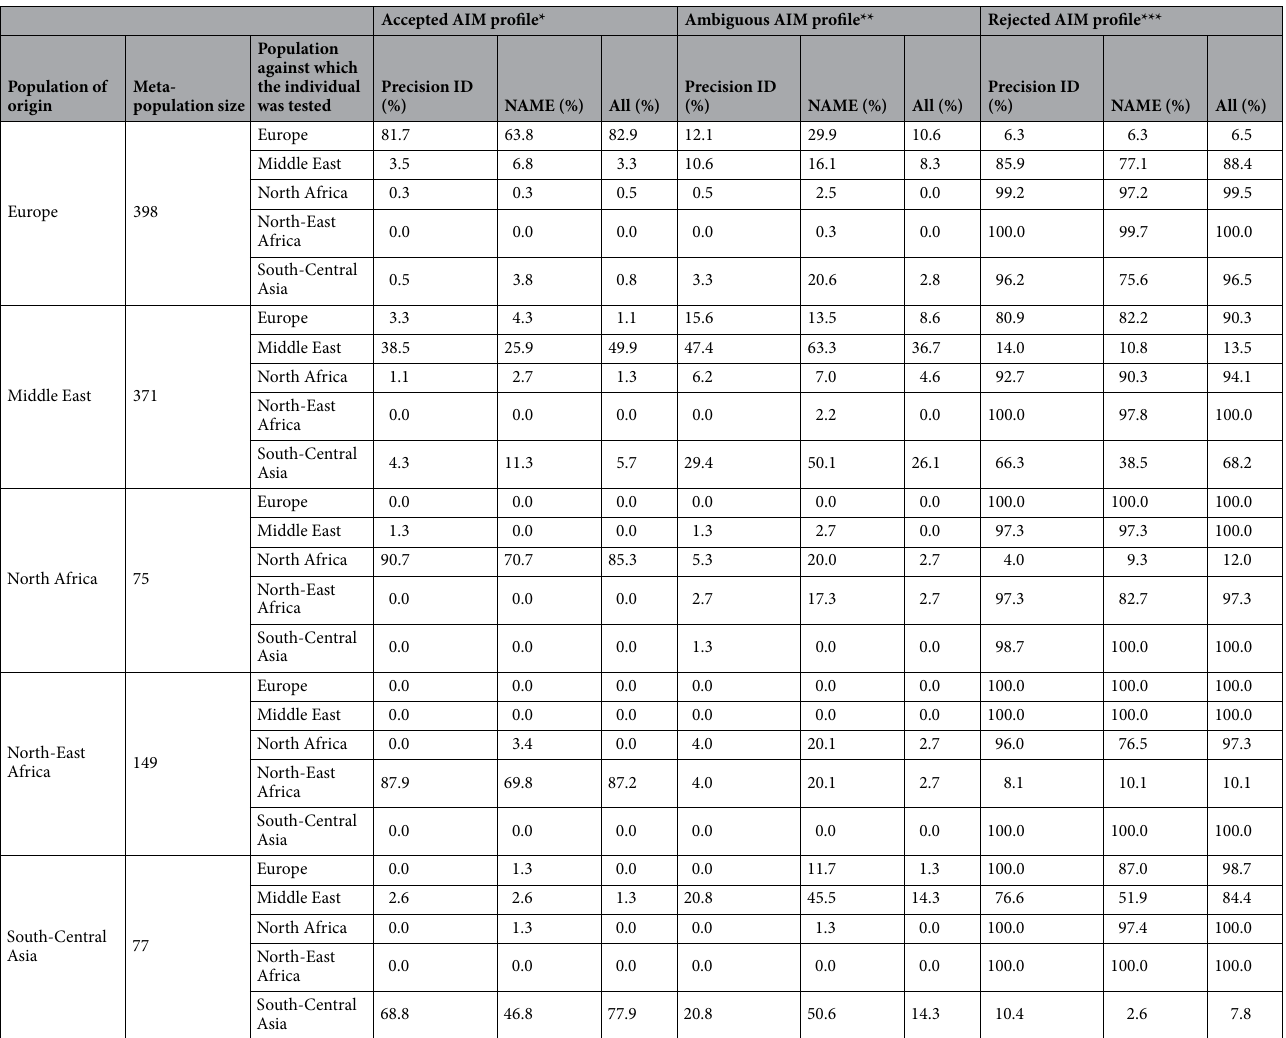
Table 1. Effectiveness of the ancestry estimation with the Precision ID Ancestry Panel, the EUROFORGEN NAME panel, and the combined panel. *Accepted: The AIM profi1e was (1) accepted in only one meta- population (z-score ≤ 1.64; P ≥ 0.05) or (2) accepted in more than one meta-population (z-score ≤ 1.64; P ≥ 0.05) and the likelihood of the AIM profile belonging to the population was statistically significantly higher than those of all other likelihoods ( P < 0.05). **Ambiguous: The AIM profile was (1) accepted in more than one meta-population (z-scores ≤ 1.64; P ≥ 0.05) and (2) the population likelihoods were not statistically significantly different from each other (z-scores ≤ 1.64; P ≥ 0.05). ***Rejected: The AIM profile was not accepted in any meta-population (z-score > 1.64; P <